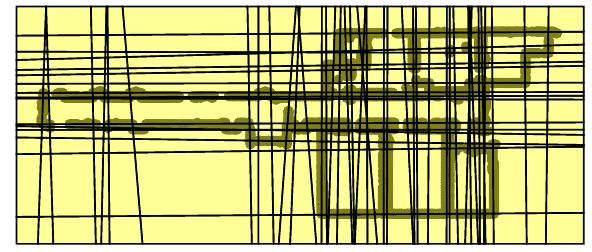
Figure 4. Cell-complex determined by the line arrangement. aligned with the dominant orientations. Their samples are then projected onto the closest edge along the direction orthogonal to the line itself, within a threshold of 60 cm.